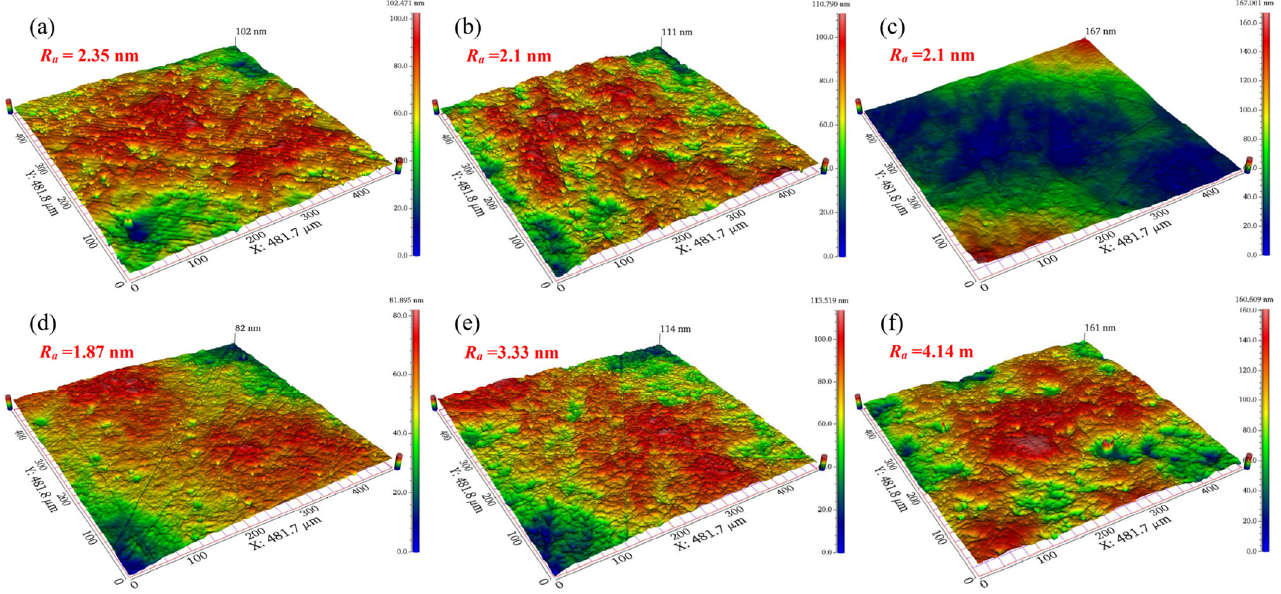
Figure 9. Surface morphologies of polished tungsten under different H 2 O 2 concentrations: ( a ) 0 vol.%; ( b ) 0.1 vol.%; ( c ) 0.5 vol.%; ( d ) 1.0 vol.%; ( e ) 1.5 vol.%; ( f ) 2.0 vol.%.